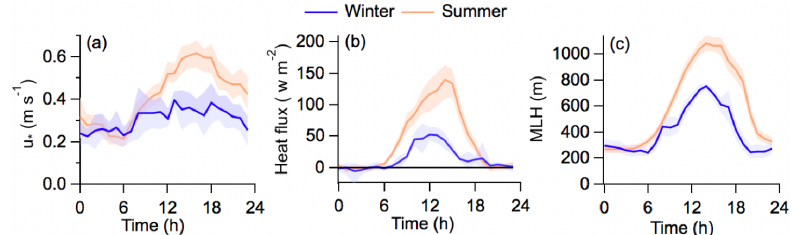
Figure 2. Winter (blue) and summer (orange) diurnal pattern of (a) friction velocity ( u ∗ ), (b) sensible heat flux and (c) mixed layer height (m). Shaded areas are the interquartile ranges, and the solid line is the